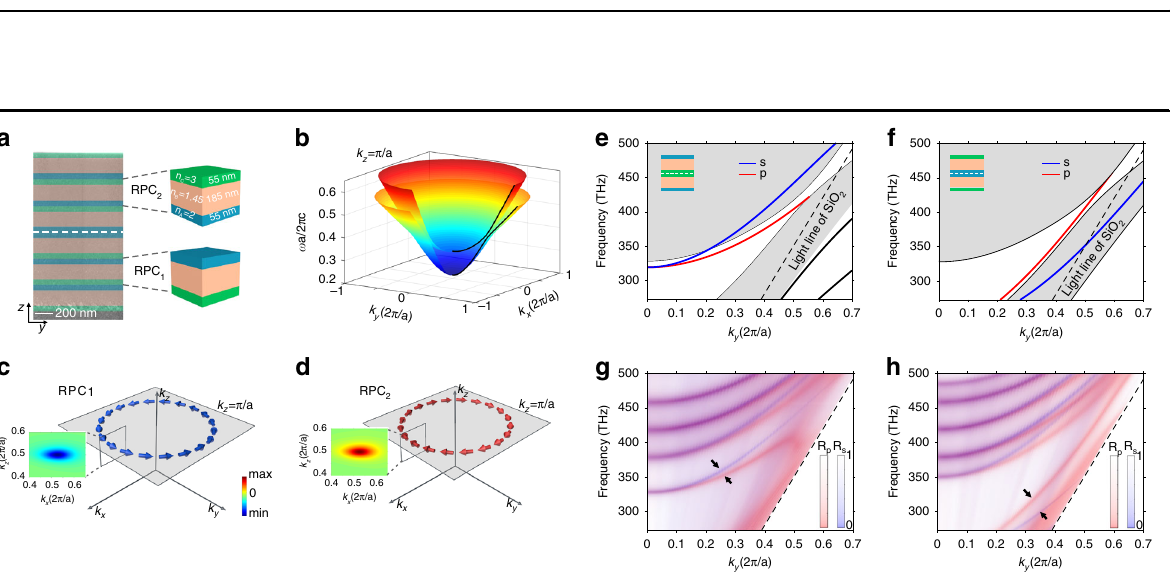
Fig. 5 Gapped ridge state induced by inversion symmetry breaking. a Left panel: SEM image of the RPC 2 -RPC 1 domain wall. The white dashed line highlights the boundary. Right panel: Two types of ridge photonic crystals (RPC 1 and RPC 2 ). b Bulk band structure of RPC 1 on the plane of k z = π / a with a partial gap opened in the vicinity of nodal ring. c , d Localized Berry vortexes for two RPCs. The insets show the cross-sectional views of the Berry curvature. Note that the Berry vortexes of two RPCs fl ow in opposite directions (clockwise or counter-clockwise) since they are linked by inversion. e Projected band of RPC 1 – RPC 2 domain wall. Gapless surface states traverse the partial gap due to the opposite Berry vortexes of two RPCs. g Measured angle-resolved re fl ection spectra for both polarizations. Two lines of re fl ection dips (highlighted by the black arrows) inside the bandgap demonstrates the topological surface states. f , h Similar to ( e ) and ( g ), but for RPC 2 -RPC 1 domain